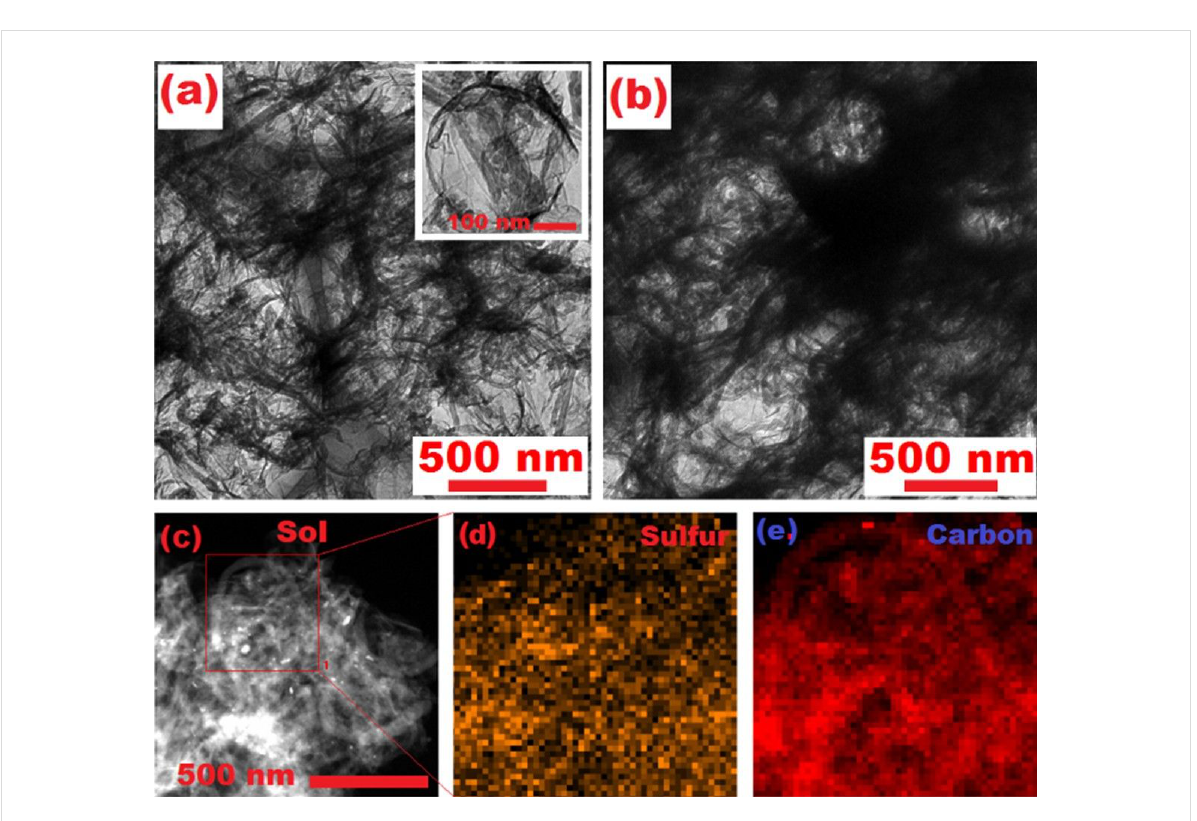
Figure 3: TEM images of (a) 3D-RGO@MWCNT with two different magnifications, (b) S-3D-RGO@MWCNT, (c–e) TEM mapping of (d) sulfur and (e) carbon corresponding to the area outlined by the red square in the TEM image of